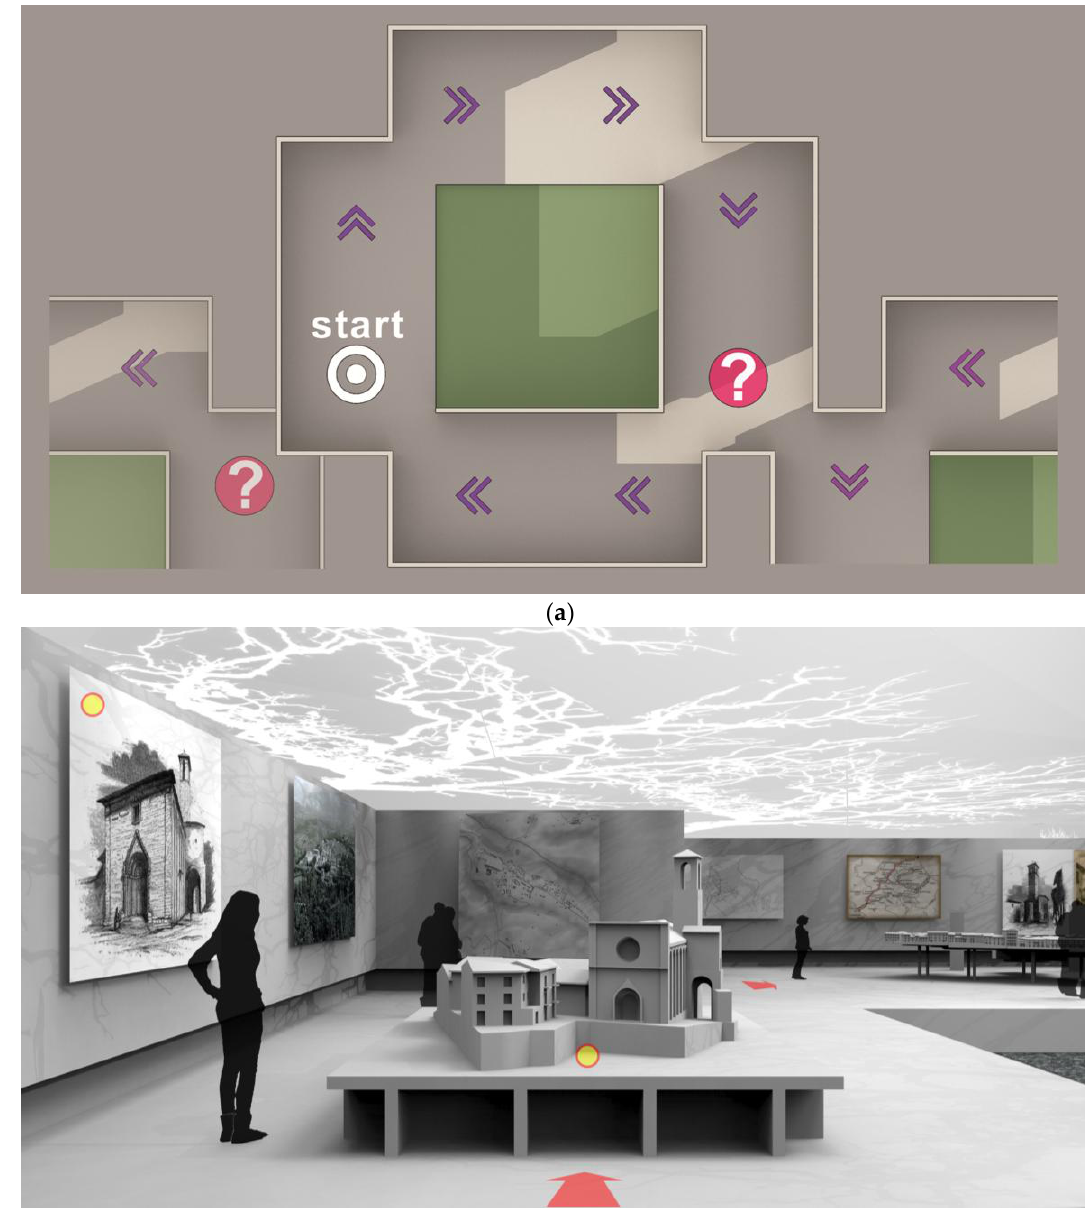
Figure 3. ( a ) The virtual museum model proposes a cross-shaped plan repeated in sequence, creating an ideally infinite space; ( b ) Movement within the MUVAT occurs through arrow interaction. Virtual content browsing is done by clicking